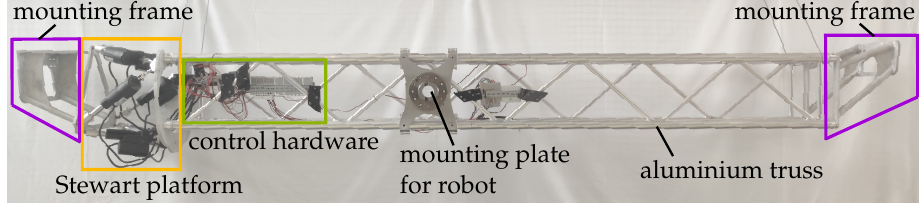
Figure 7. end effector used for assembly experiments Figure 7. End effector used for assembly